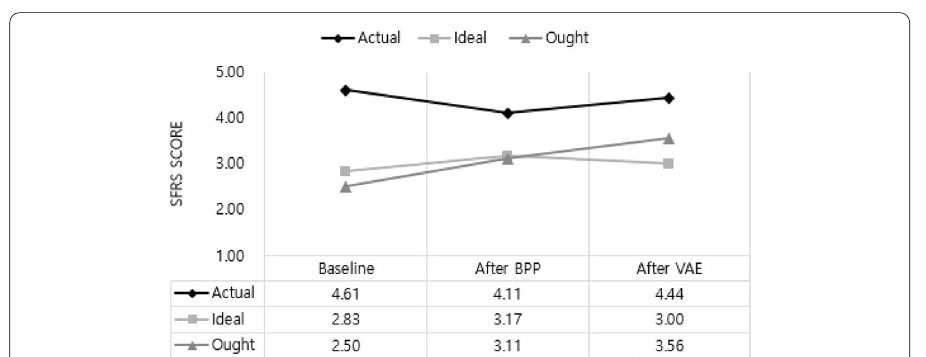
Fig. 4 Comparisons of self-body perception ratings across the intervention